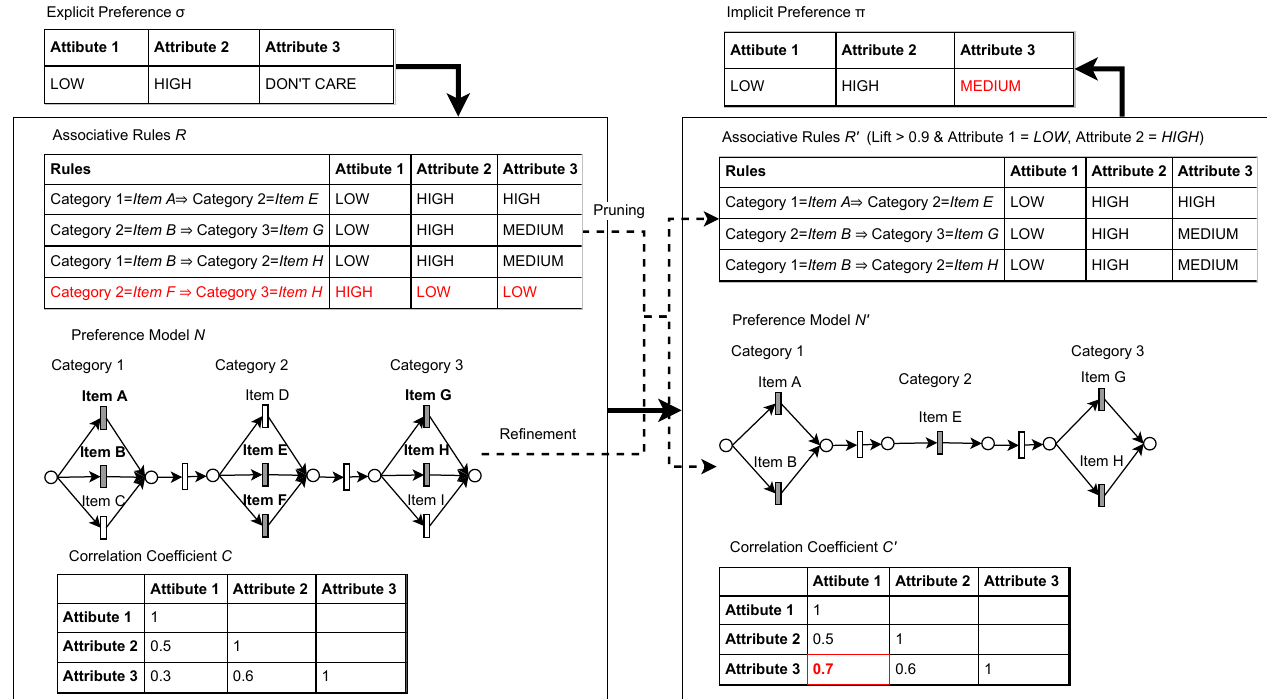
Figure 4. The detailed we added the explanation of red part overview of our approach. The input is explicit preference σ , and the output is implicit preference π . Both preferences are bounded by attributes and items in associative rules R and preference model N . The red part shows preferences that adapt to